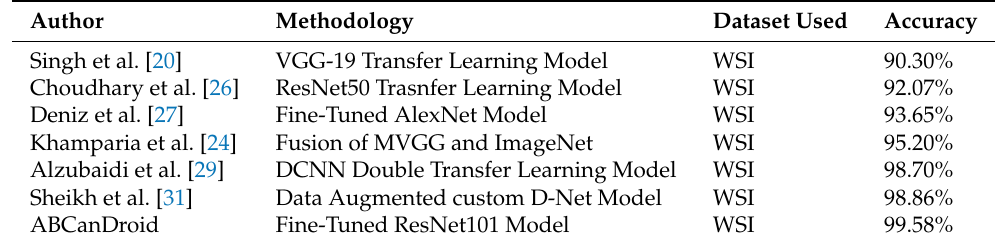
Table 9. Resulting comparison of the related